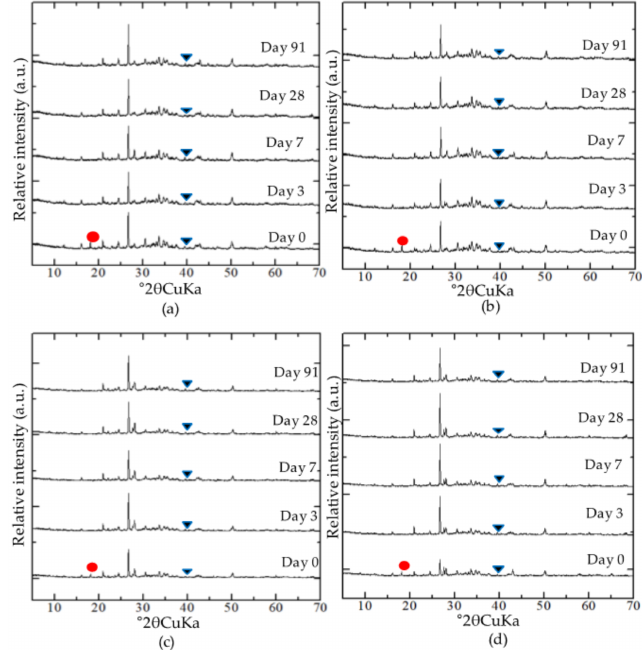
Figure 9. XRD profiles of mixtures cured for 0, 3, 7, 28 and 91 days of ( a ) mixture 2A, ( b ) mixture 2B, ( c ) mixture 2C, and ( d ) mixture 2D. Red circle corresponds to portlandite and black triangle corresponds to larnite.